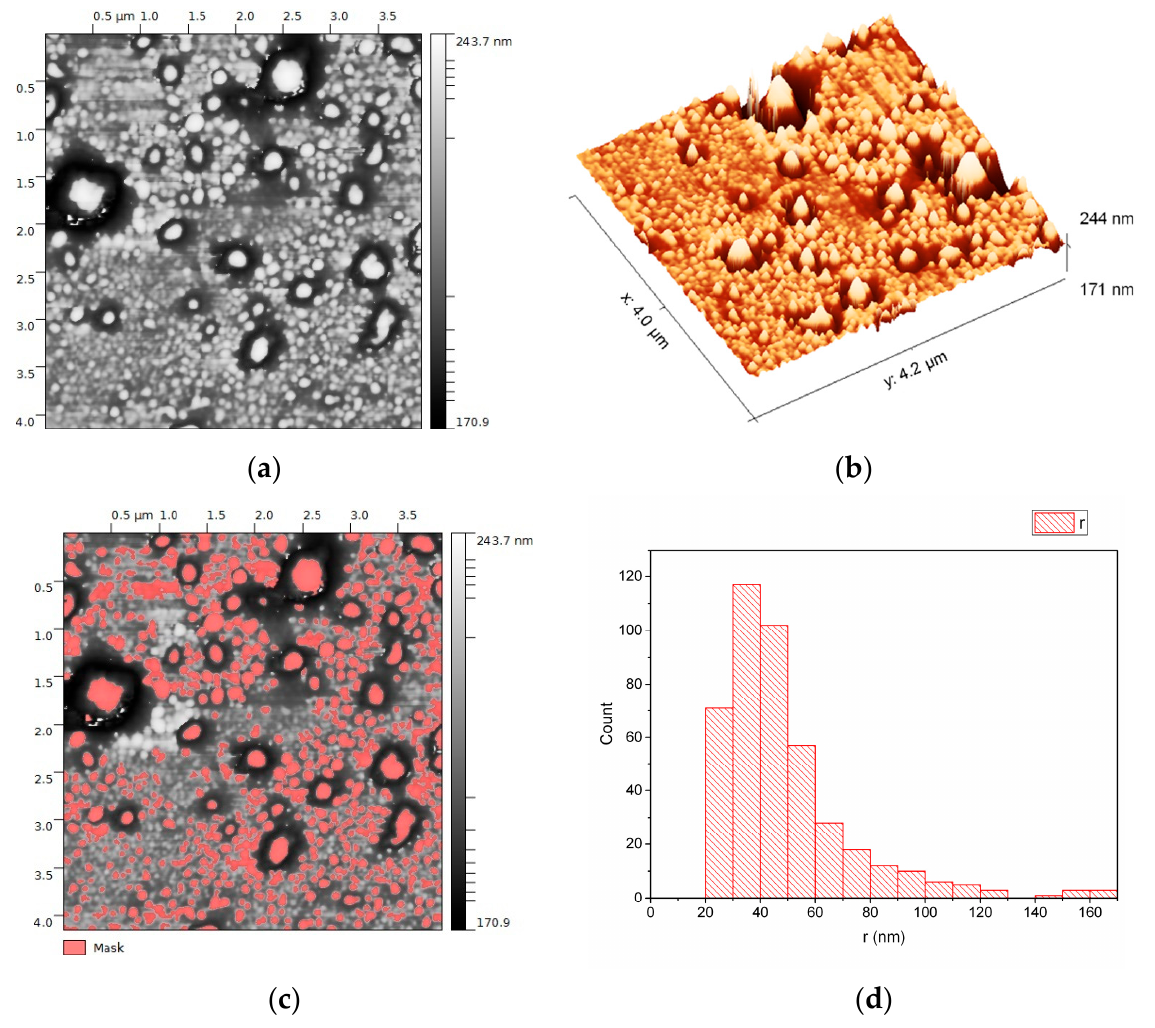
Figure 3. Non-contact mode (170 kHz) atomic force microscopy (AFM) of intact EVs isolated from 500 µ L of plasma from a single patient with pediatric HL: ( a ) 2D AFM image of EVs diluted 1:100; ( b ) 3D AFM image of EVs diluted 1:100; ( c ) mask detection of the vesicles for statistical analysis; ( d ) radius size distribution of EVs.